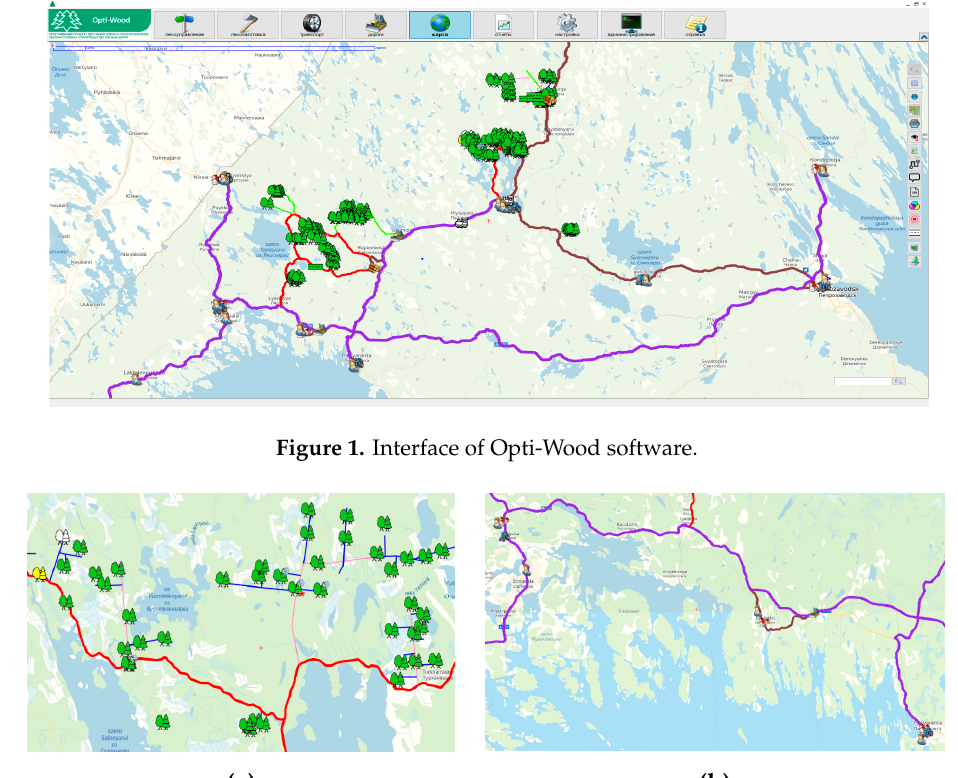
Figure 2. Spatial distribution of ( a ) harvesting sites and ( b ) other objects.